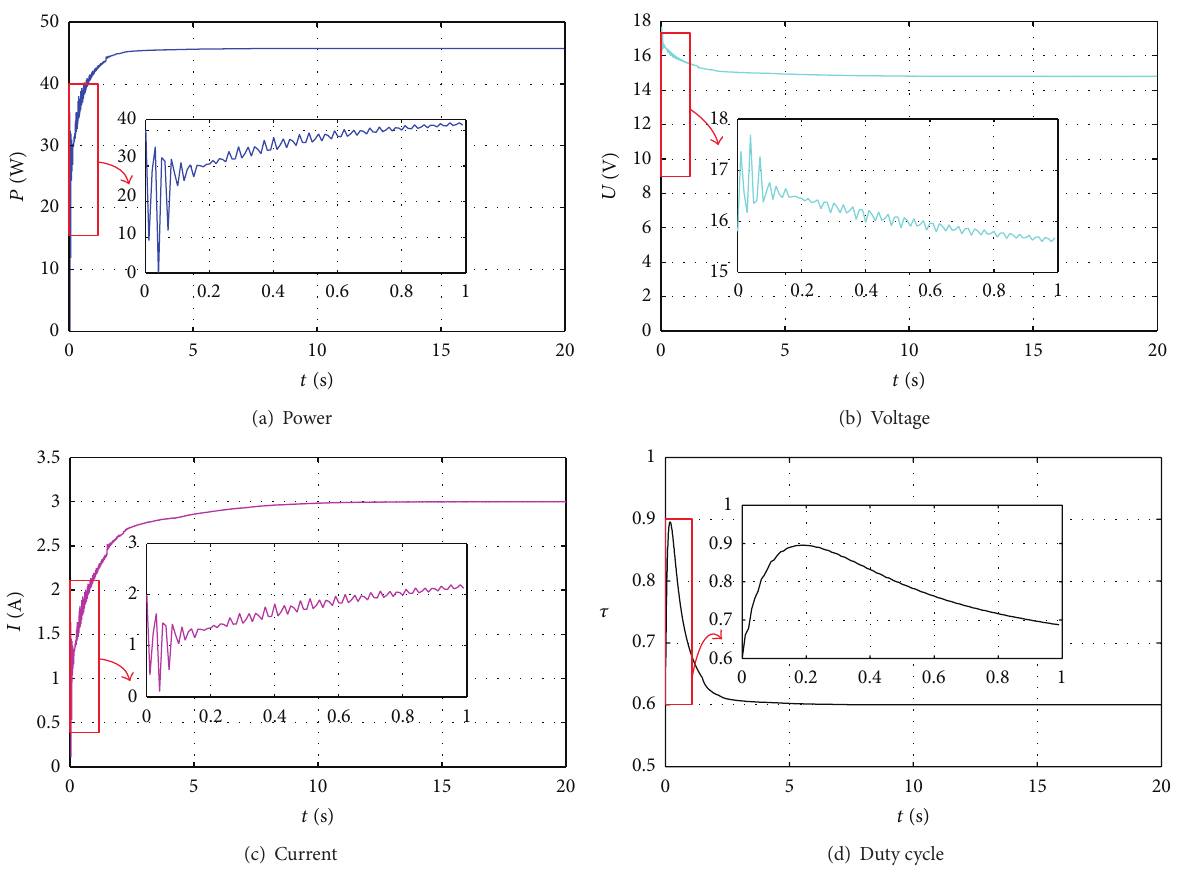
Figure 11: Simulation results of the proposed MPPT method under uniform irradiance of 800W/m 2 at 25 ∘ C.